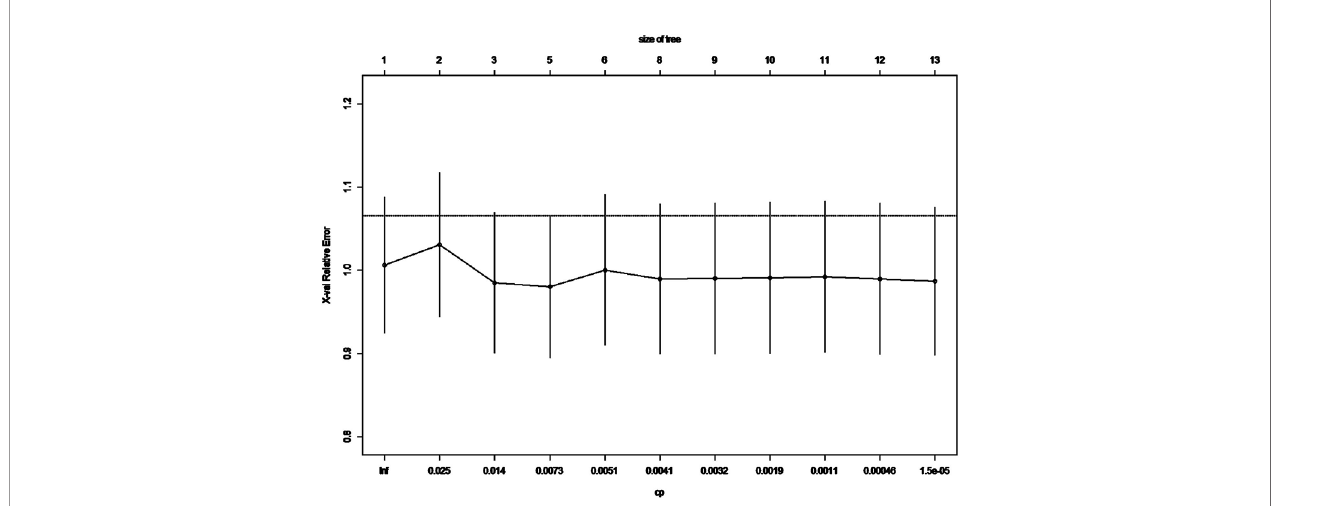
FIGURE 5 | Cross-validation relative error vs. numbers of split and complexity parameter; the lowest CV error rate can be achieved when nsplit reaches